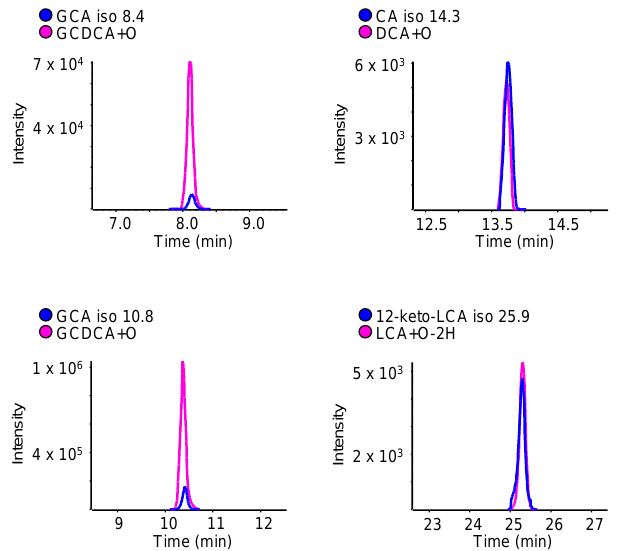
Figure 5. High-resolution extracted ion LC-MS chromatograms of isomers overlaid from rat plasma samples (in blue) and in vitro incubation samples with standard bile acids (in pink).